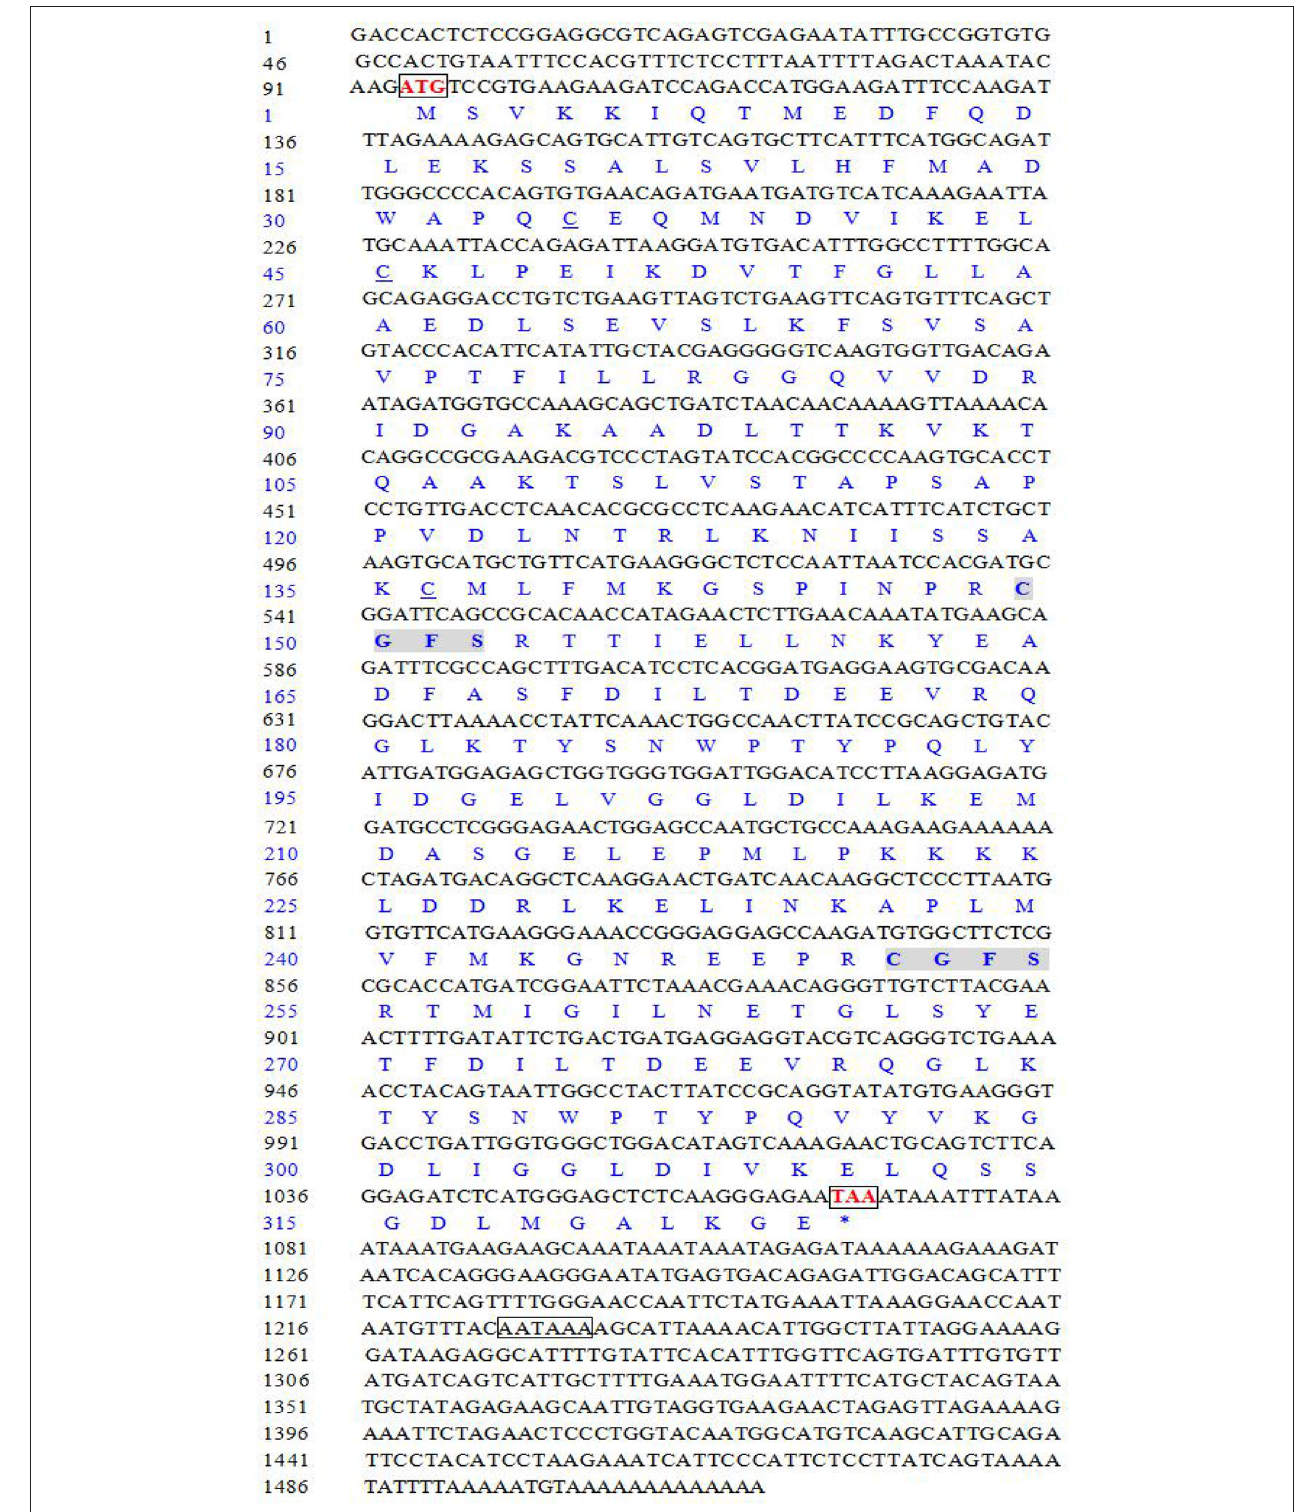
FIGURE 1 | Nucleotide and deduced amino acid sequences of Grx 3 gene of Pacific white shrimp ( Litopenaeus vannamei ). The letters in box indicate start codon (ATG), stop codon (TAA), and polyadenylation signal sequence (AATAAA). The catalytic amino acids (C-G-F-S) are shaded in gray. The other cysteine residues, Cys 34 , Cys 45 , and Cys 136 in LvGrx 3 are